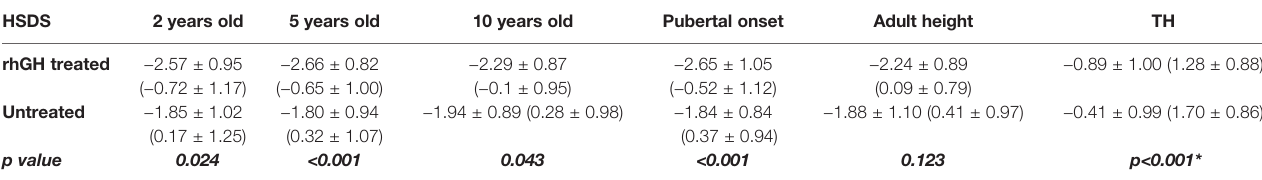
TABLE 3 | HSDS in NS treated and untreated